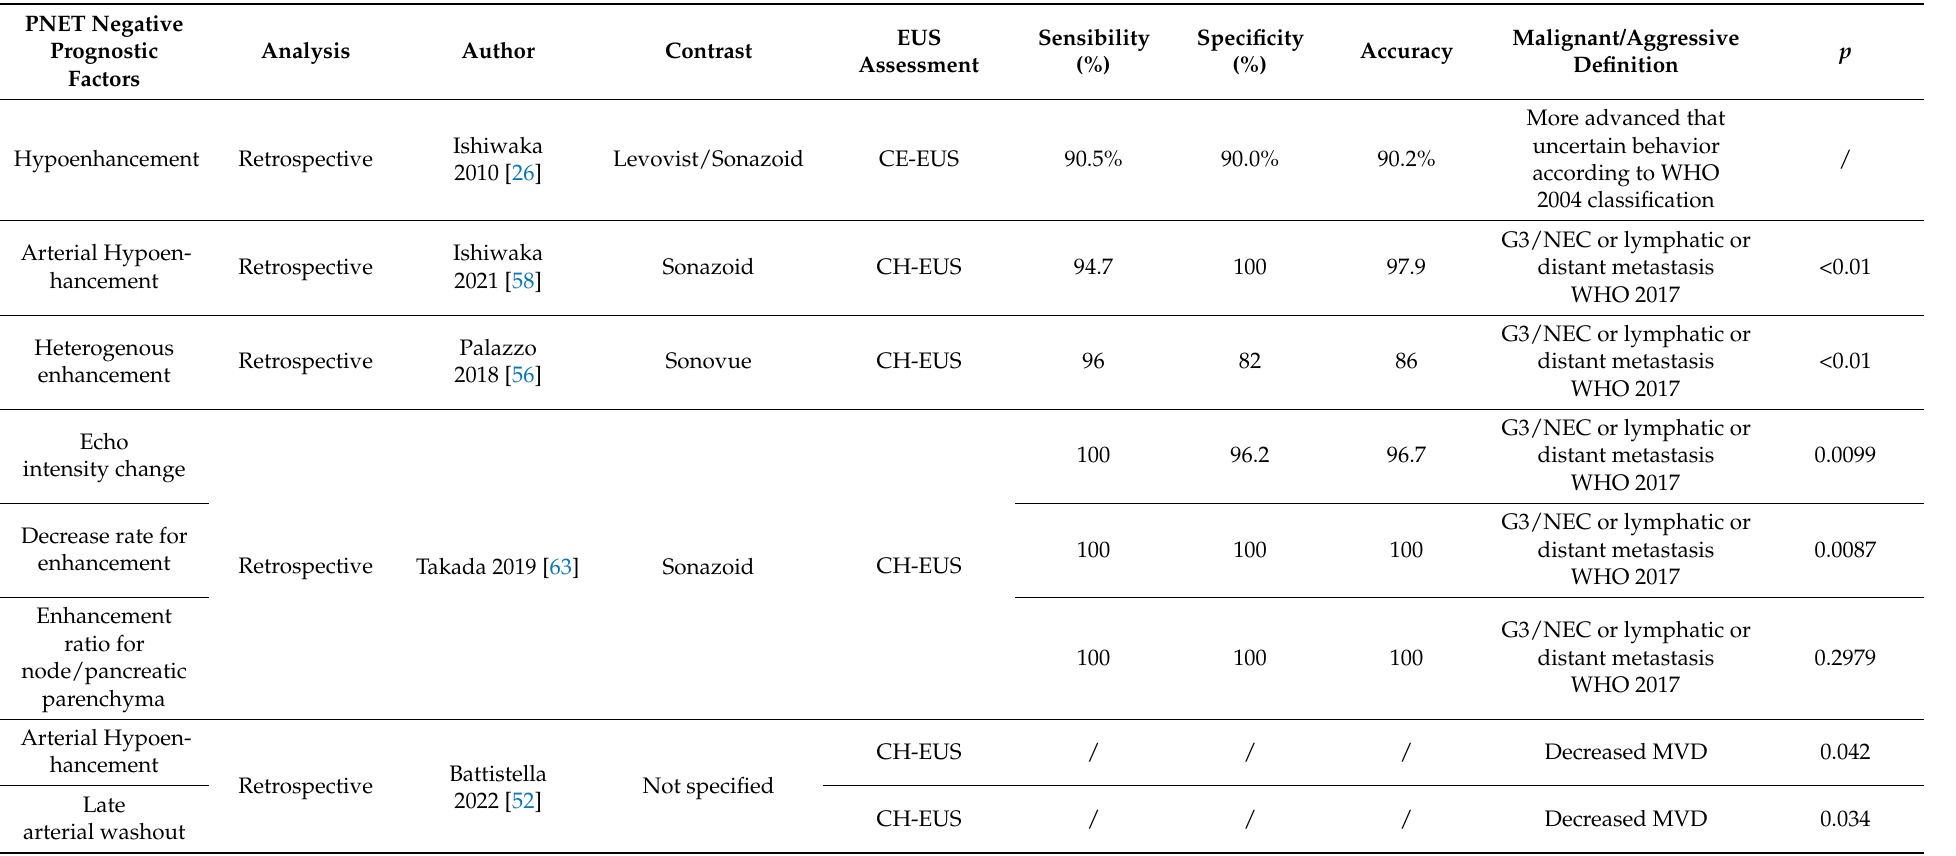
Table 1. Negative prognostic factors of PTENs in CE/CH-EUS. CE-EUS: contrast-enhanced endoscopic ultrasonography, CH-EUS contrast-enhanced